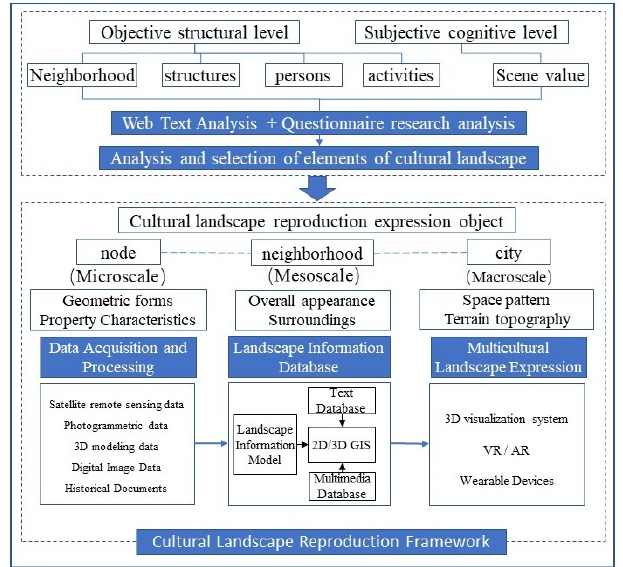
Figure 3. The overall framework of cultural landscape reproduction based on scene